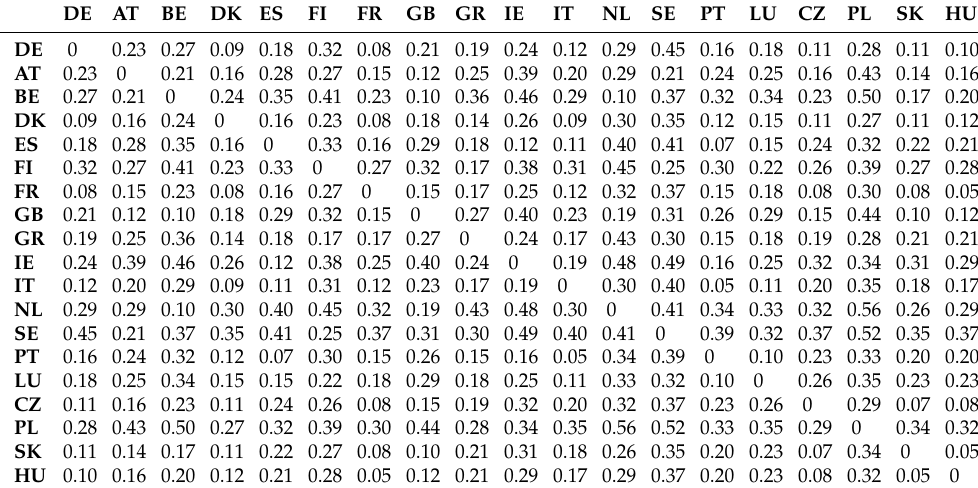
Table A2. Structure diversity matrix of energy use sources in the food production systems in 2015–2016 ( γ =